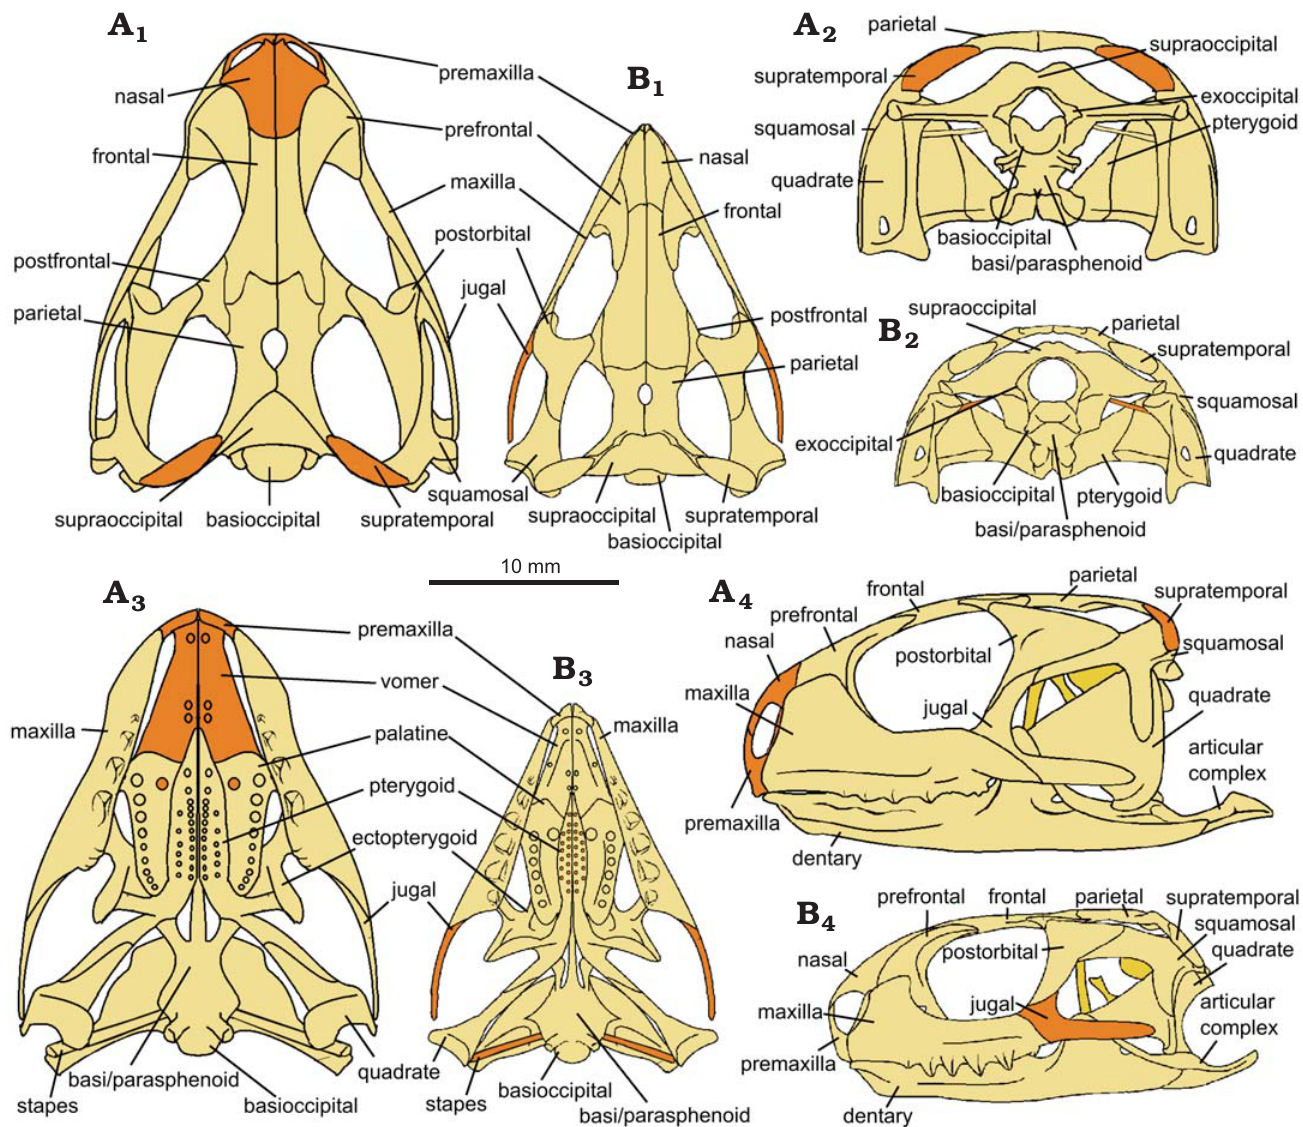
Fig. 12. Reconstruction of the skulls of lepidosaur rynchocephalians. A . Clevosaurus hudsoni Swinton, 1939 (based on NHMUK PV R36832). B . Clevosaurus cambrica Keeble, Whiteside, and Benton, 2018 (based on NHMUK PV R37014). In dorsal (A 1 , B 1 ), posterior (A 2 , B 2 ), ventral (A 3 , B 3 ), lateral (A 4 , B 4 ) views. Bones types that are absent in their respective datasets are highlighted in orange. Note that the pterygoids of C. cambrica bear two rows of multiple teeth, but the exact number of teeth at this time is